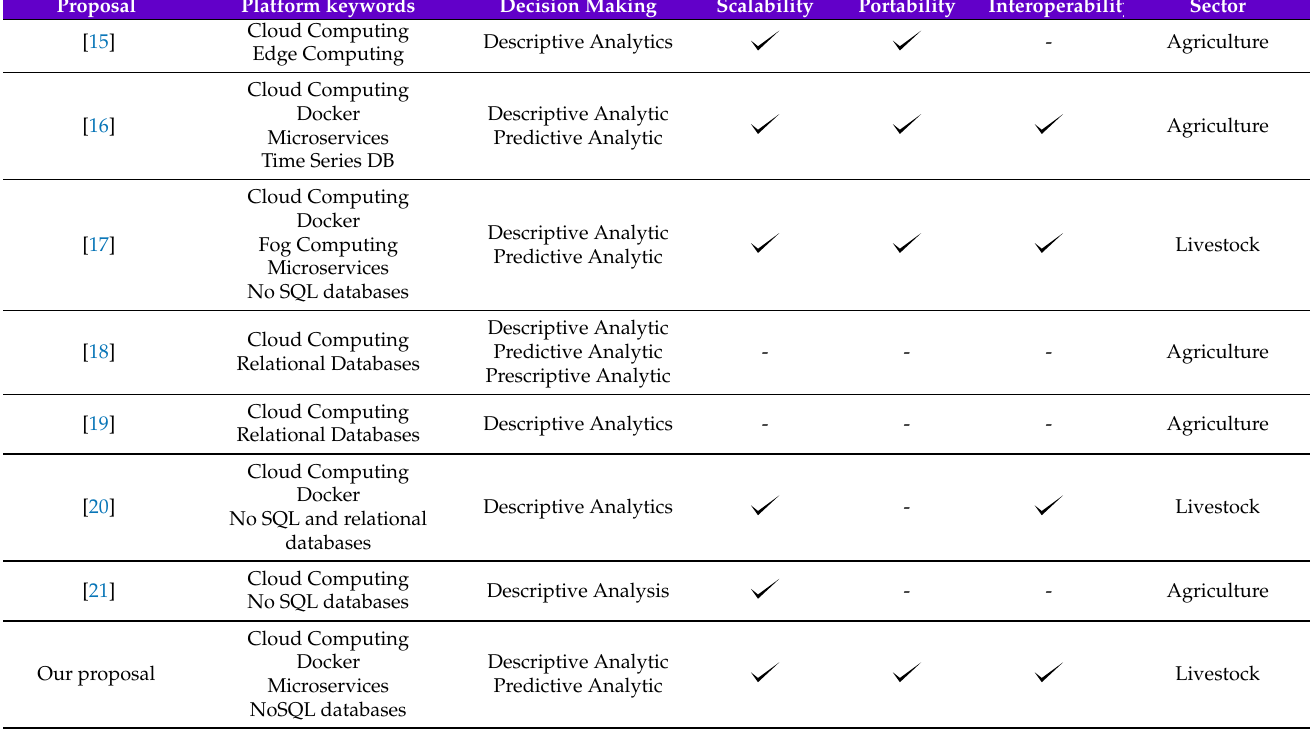
Table 1. Comparison between related